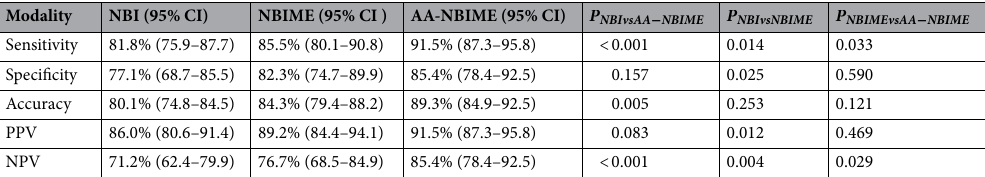
Table 4. Diagnostic performance of optical diagnosis of colorectal neoplastic polyps by three modalities for the non-expert group. PPV positive predictive value, NPV negative predictive value.